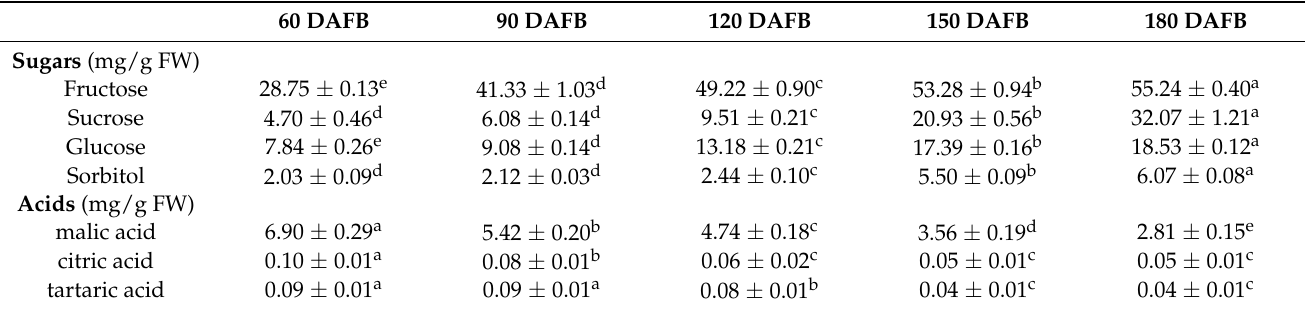
Table 2. The content of soluble sugars and organic acids in ‘Orin’ apple at different ripening